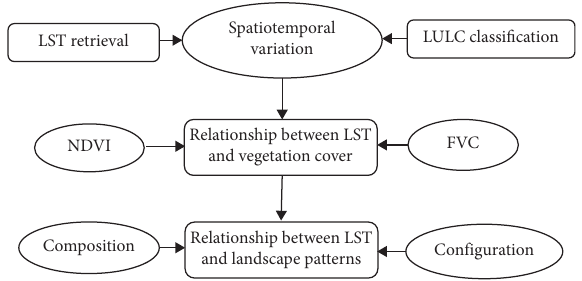
Figure 1: The sketch map of this